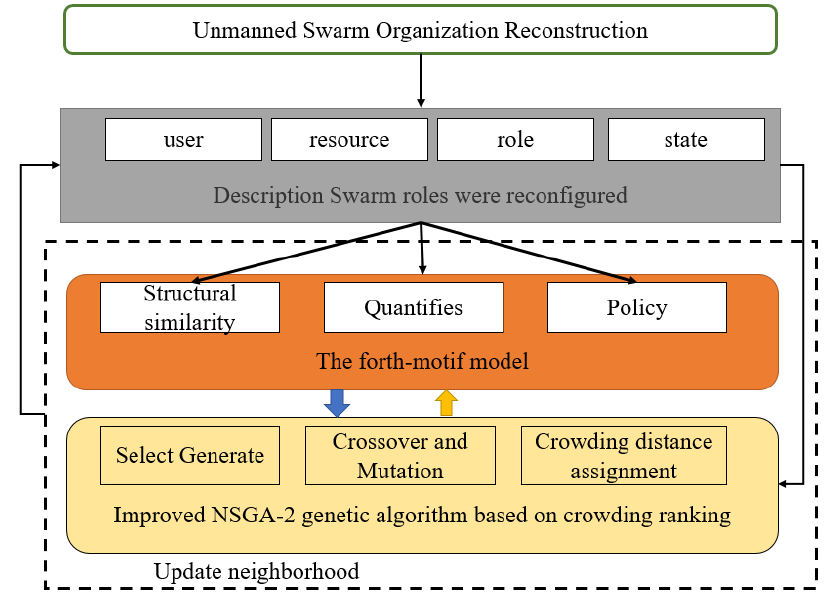
Figure 2. Dynamic role distribution